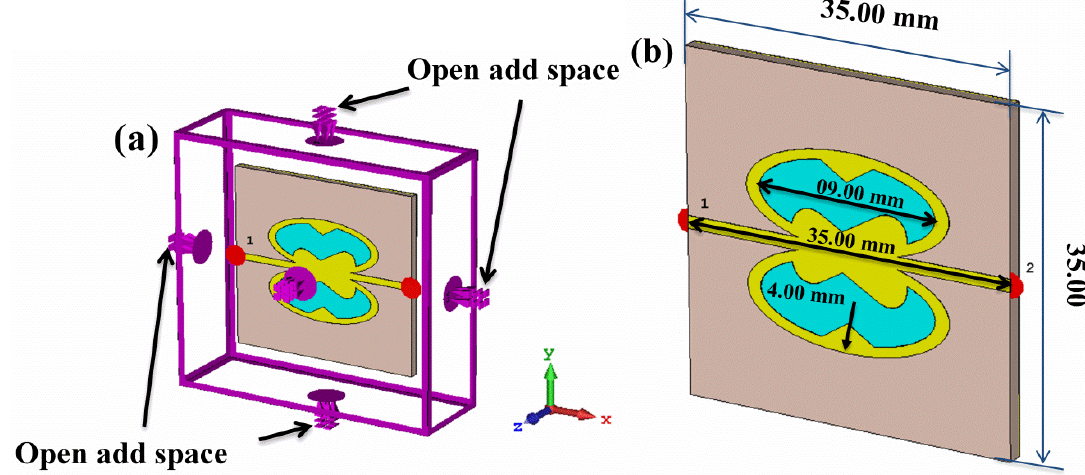
Figure 2. ( a ) The proposed metamaterial sensor: boundary condition and ( b ) optimum dimensions.